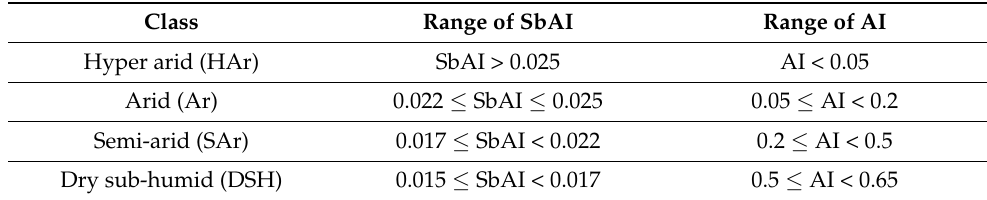
Table 1. Classification of arid regions using the SbAI and AI.